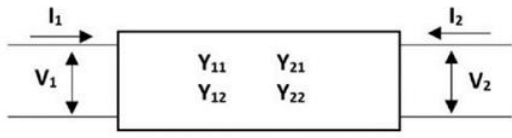
Figure 5. Admittance two-port circuital model.